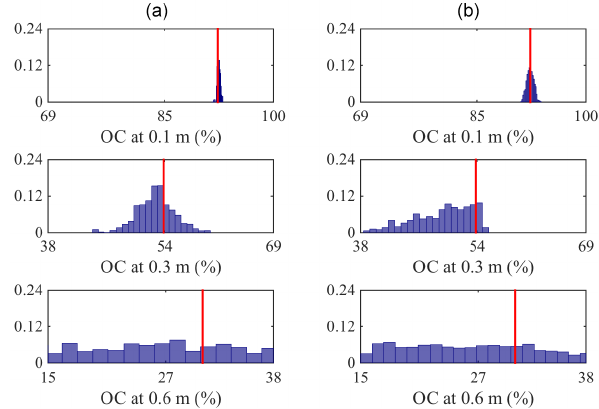
Figure 6. The a posteriori probability of the soil OC content at z = 0 . 1, 0.3 and 0.6m obtained by inverting apparent resistivity data with relative measurement error of 2% (a) and 5% (b) . The red lines represent the “true” OC